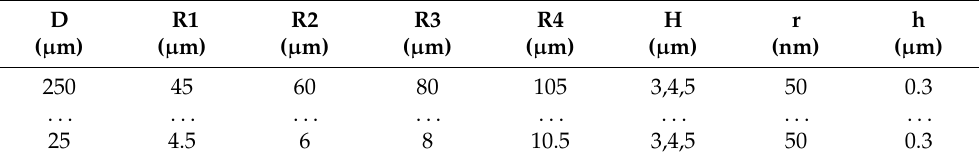
Table 1. The details of the parameters for